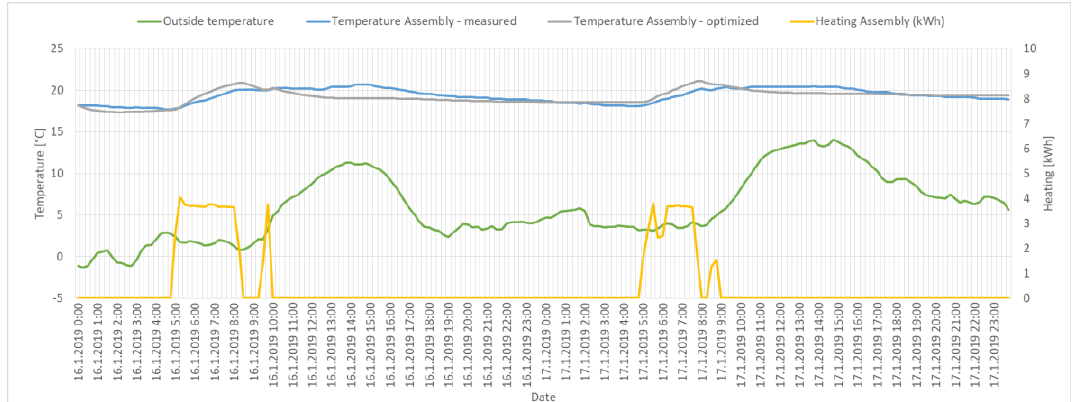
Figure 13. Results of optimized model with Winter 2-1